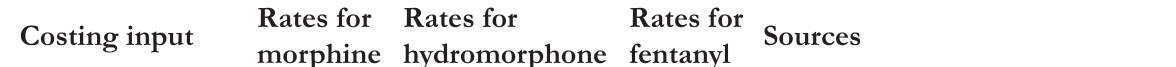
Table 6. Summary of Non-cost Input Parameters for AEs and IV